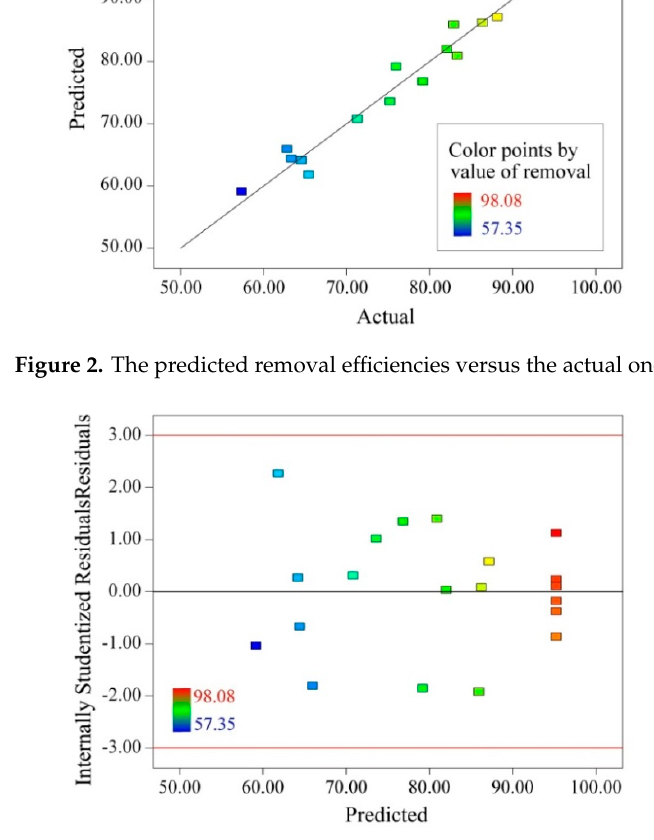
Figure 2. The predicted removal efficiencies versus the actual ones.